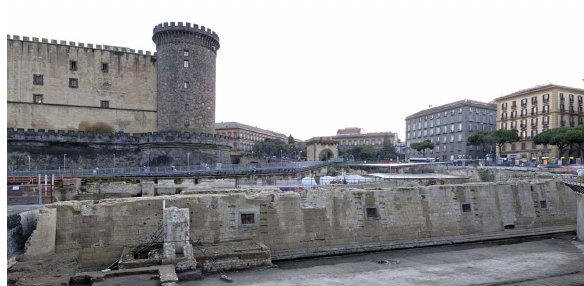
Figure 9: Piazza Municipio, findings from the Angevin period. Most of these findings can’t understood without the necessary additional information.